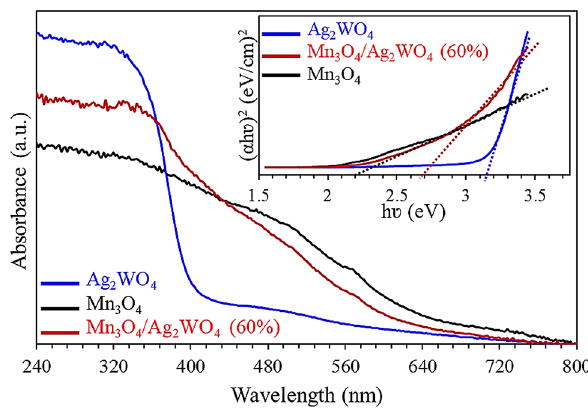
Figure 6. UV–visible spectra of α-Ag 2 WO 4 , Mn 3 O 4 and Mn 3 O 4 /α-Ag 2 WO 4 (60%) with the band gap energy plots as insets.